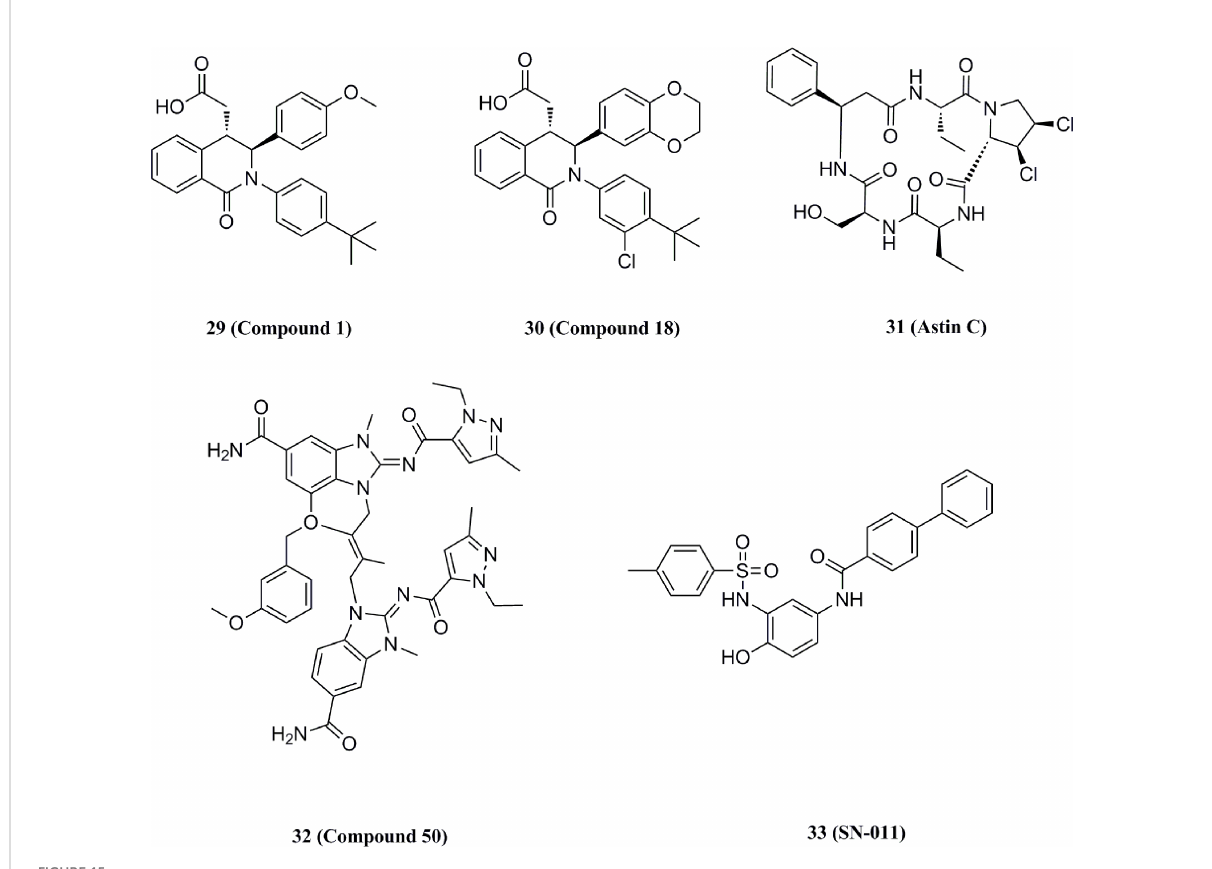
FIGURE 15 Structures of STING competitive binding